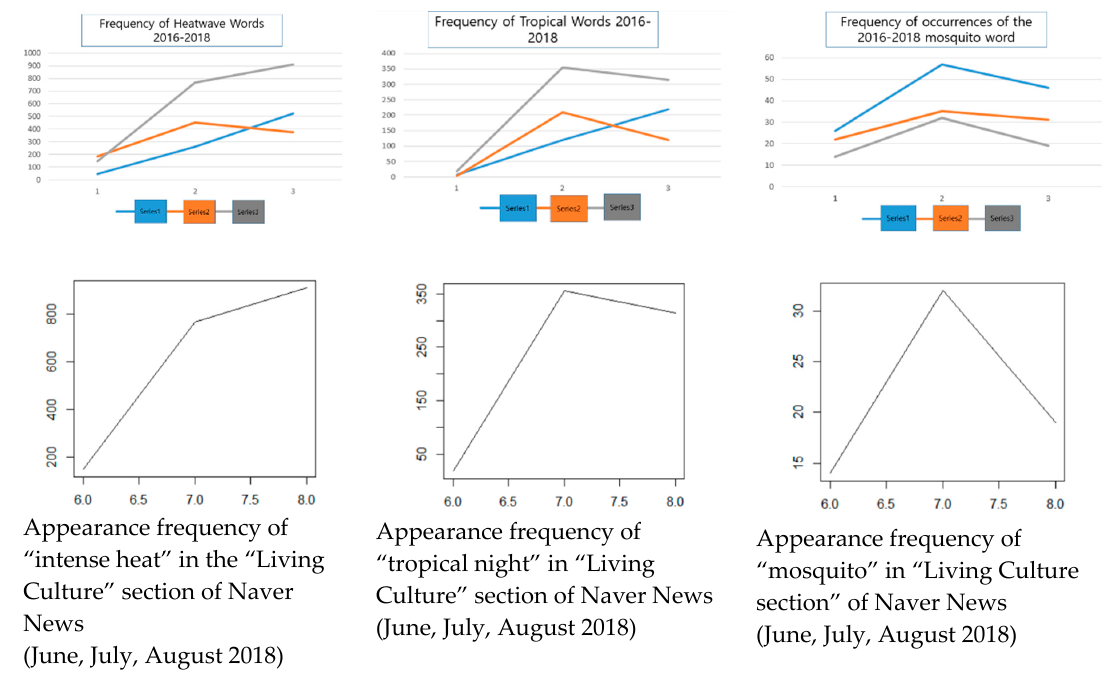
Figure 24. Longitudinal Comparison of Appearance Frequency of Relevant Words.